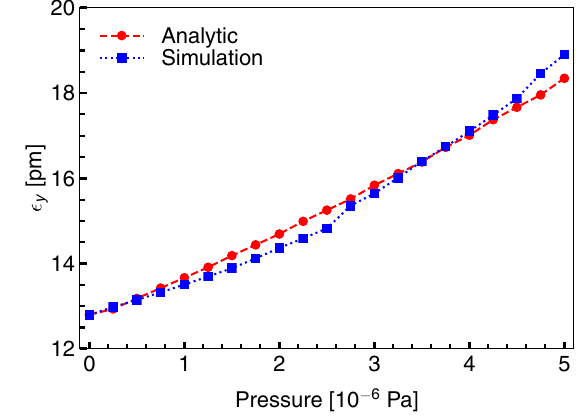
FIG. 10. Emittance growth as a function of vacuum pressure predicted by analytic calculation and Monte Carlo simulation.